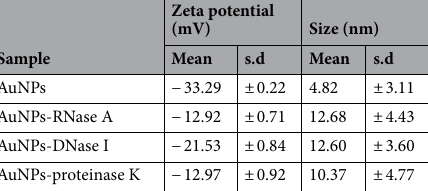
Table 1. Size (nm) and zeta potential (mV) of all AuNPs-enzyme samples and AuNPs without any enzyme